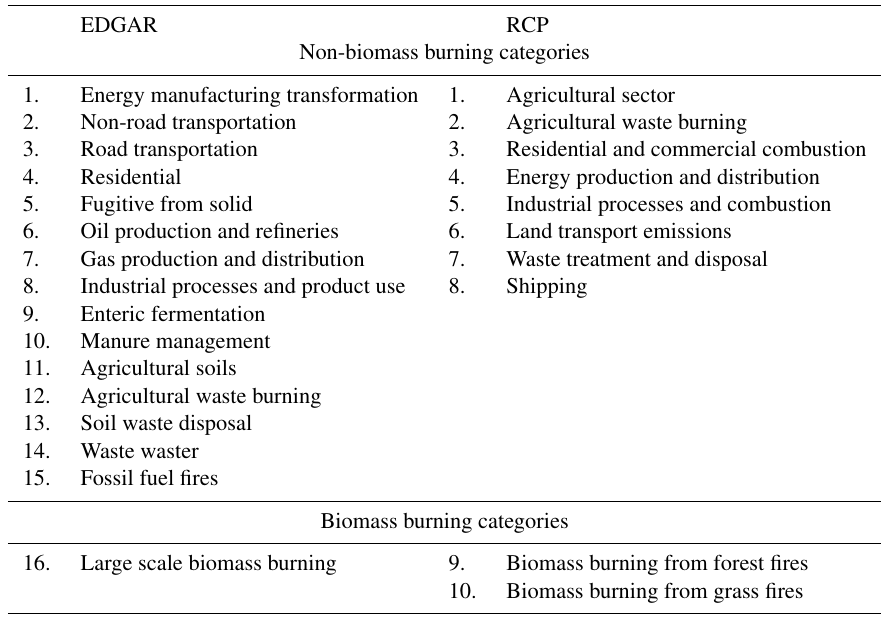
Table 1. Emissions categories for EDGAR and RCP anthropogenic methane emissions.